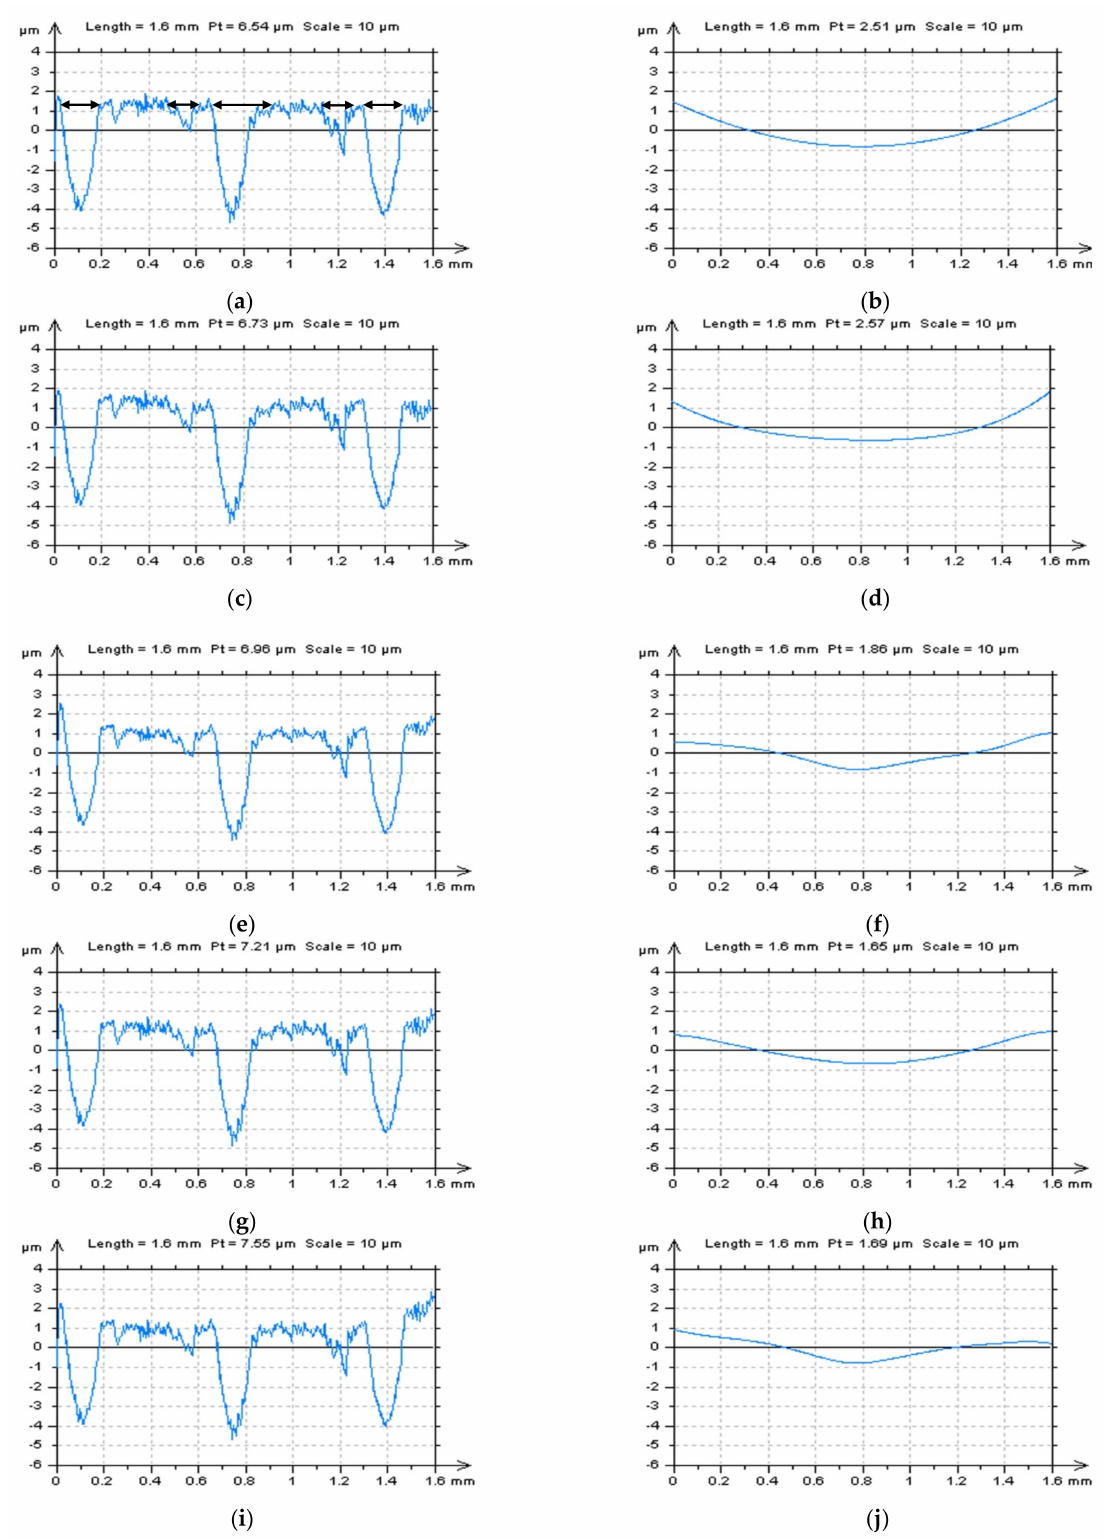
Figure 9. Profiles after L-surface definition (left column) and form removal (right column) received from the example presented previously in Figure 8a by application of Poly2 ( a , b ), Poly4 ( c , d ), GRF ( e , f ), RGRF ( g , h ), and SF ( i , j ), cutoff = 0.8